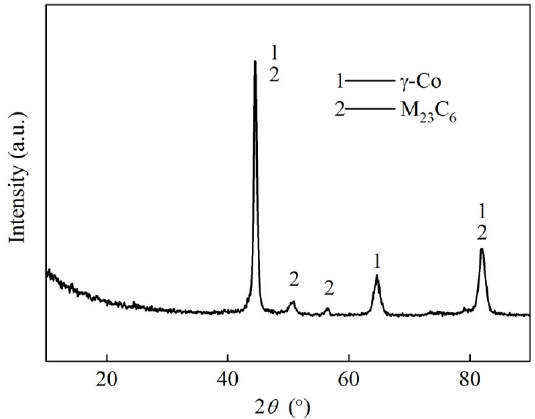
Figure 3. XRD patterns of the Co-based alloy cladding layer.